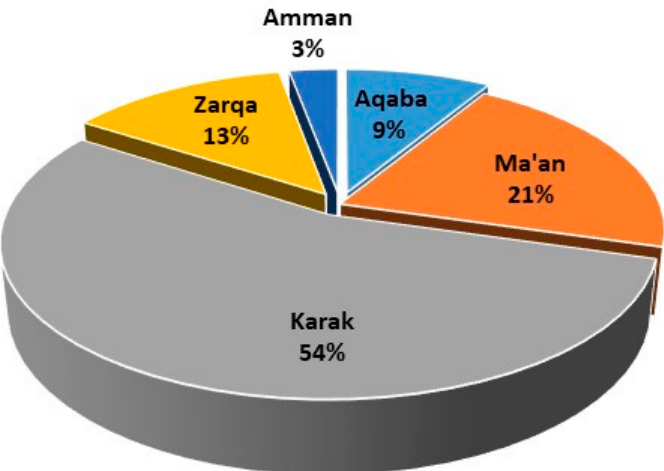
Figure 4. Classification of WWTPs according to their effluents’ TDS.